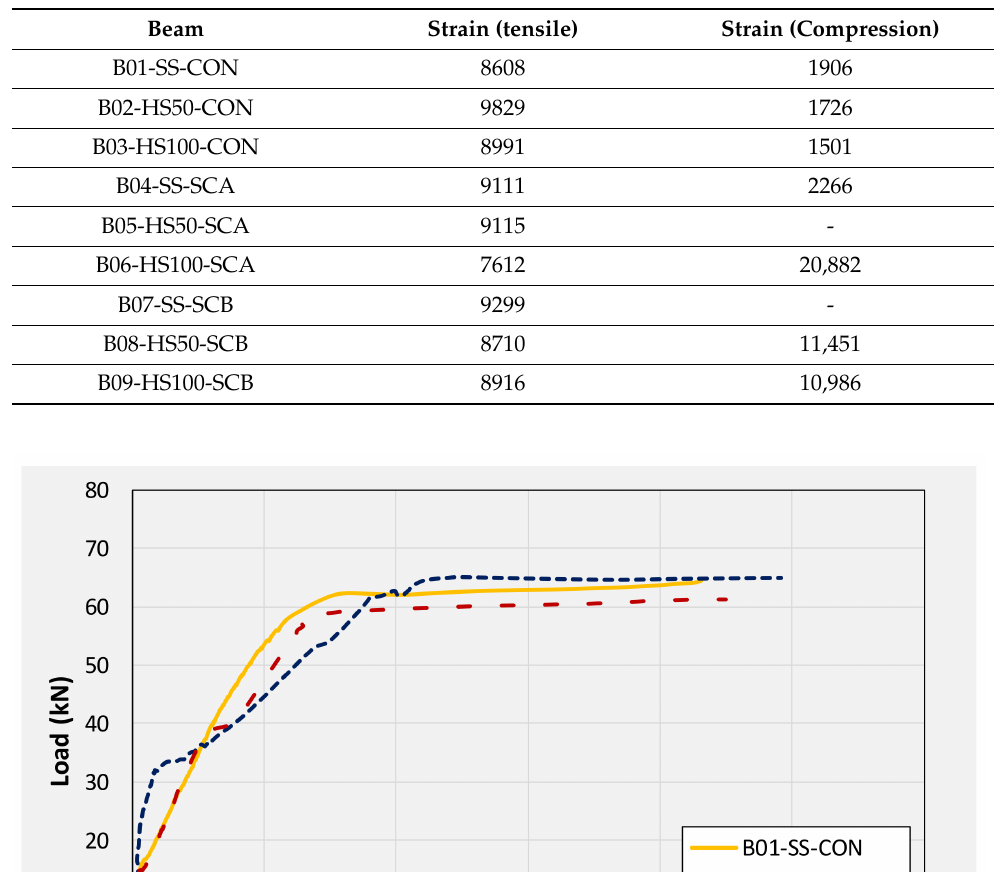
Table 4. Summary of maximum strains monitored on longitudinal steel bars.